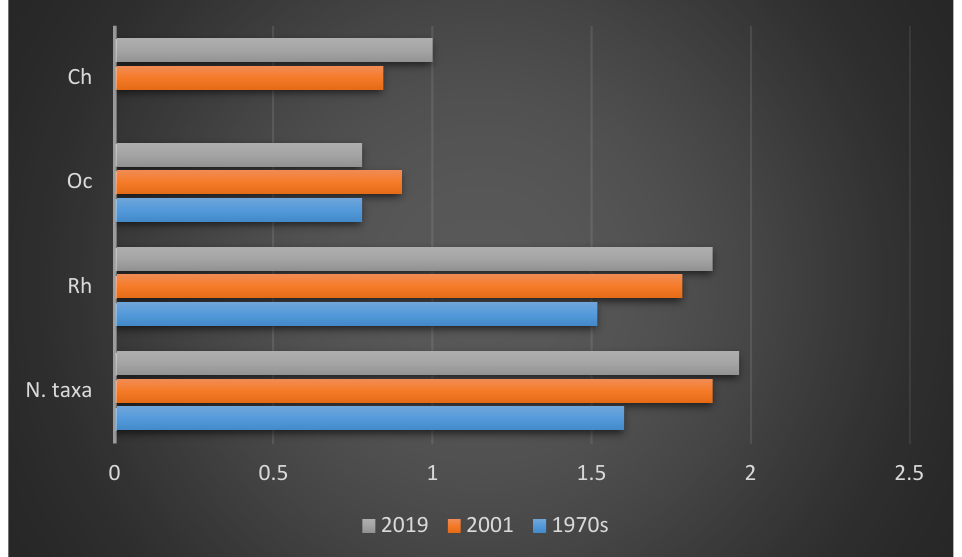
Figure 4. Logarithmic representation of the variations in the number of taxa, Rhodophyta (Rh), Ochrophyta (Oc), and Chlorophyta (Ch) from the 1970s to 2019.